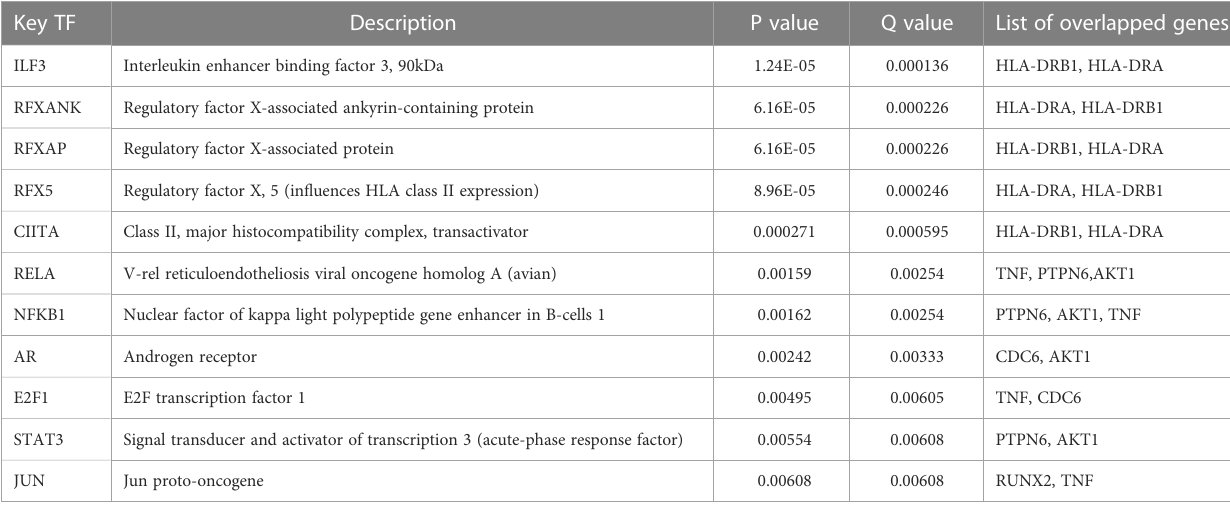
TABLE 2 Transcription factors upstream of Tex-related hub